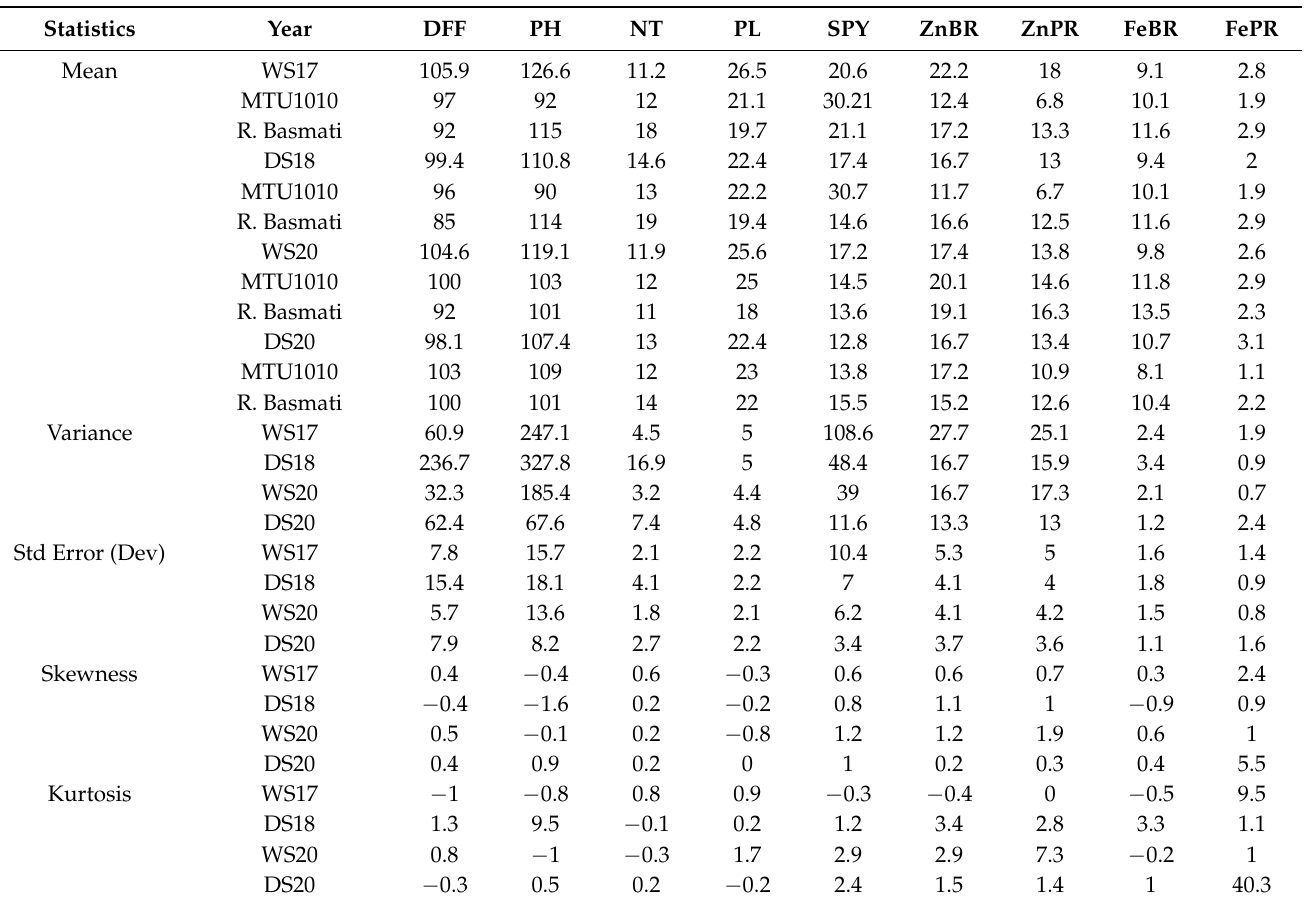
Table 1. Descriptive statistics of selected RILs (four